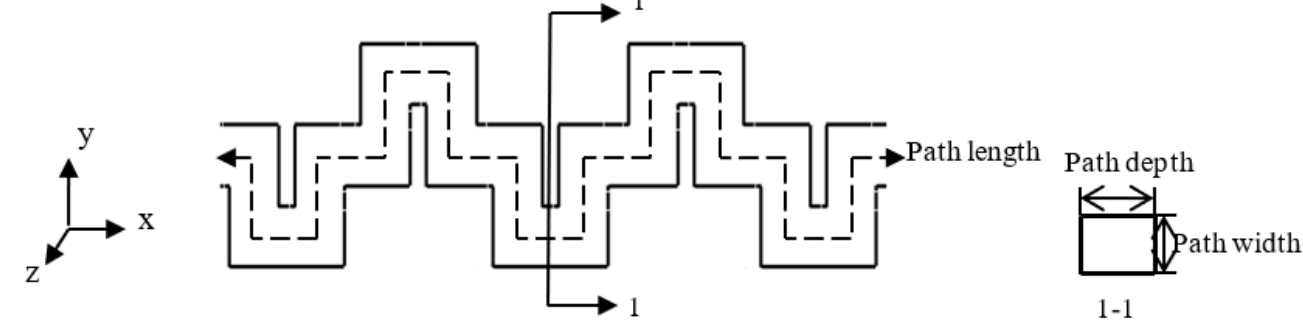
Figure 2. Minkowski fractal flow path generation schematic. ( a ) Minkowski curve; ( b ) Minkowski flow path design diagram.